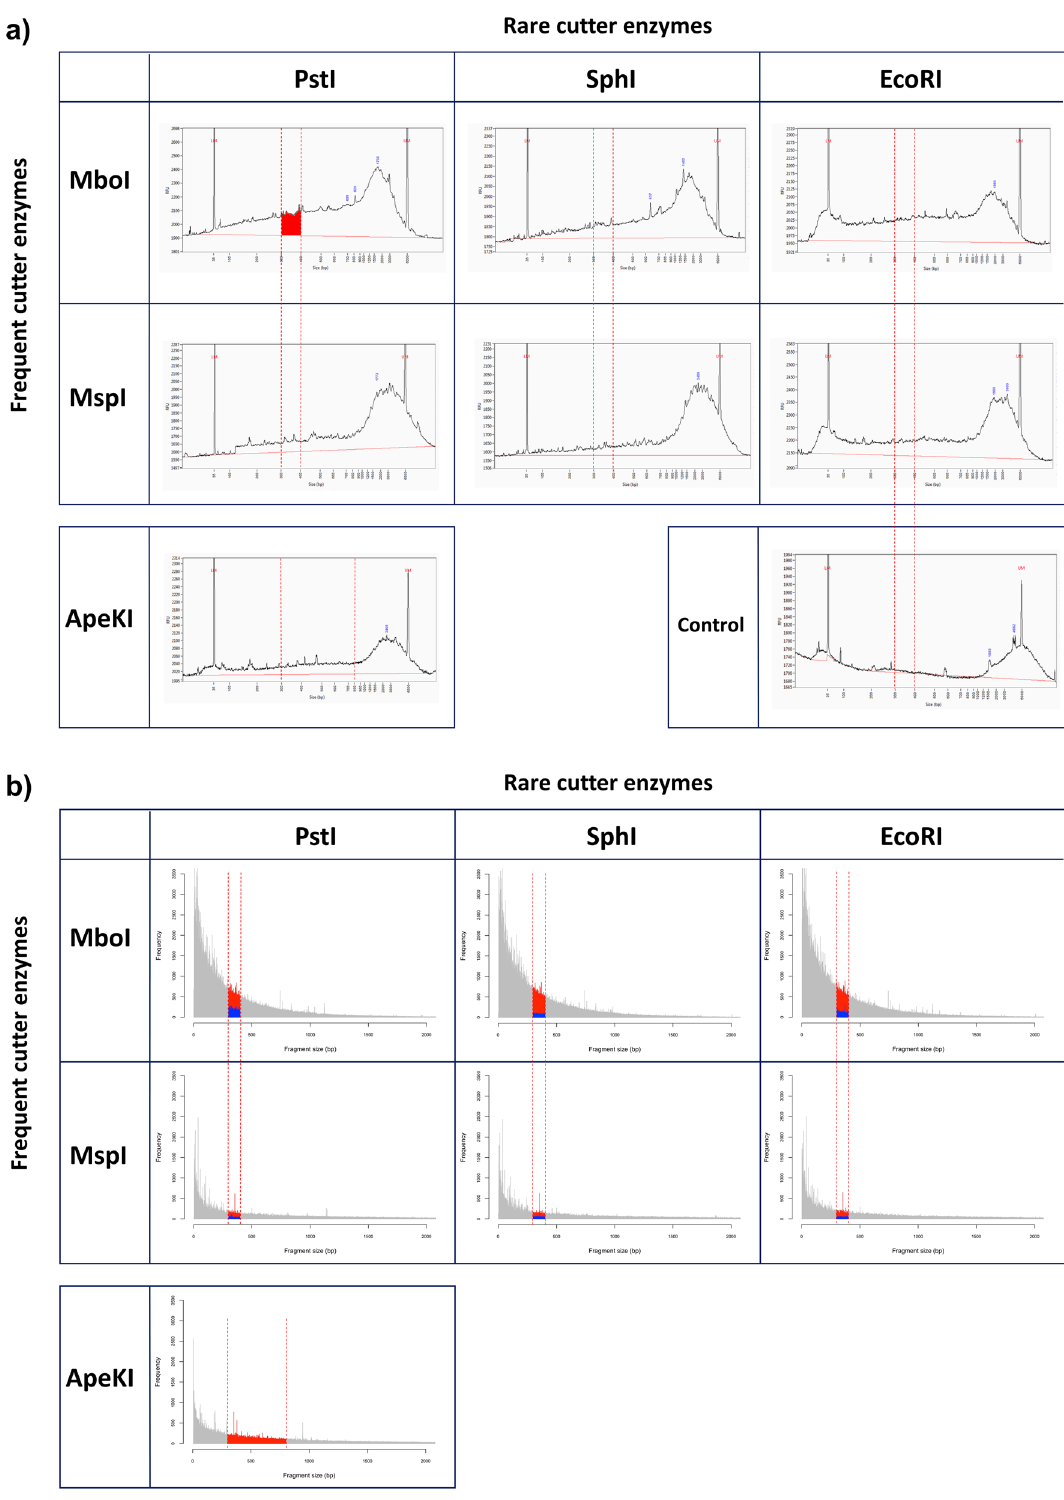
Figure 1. Reduction of genome complexity. ( a ) In vitro enzymatic restrictions. Profile of peach DNA (Dixiland) quantification by fragment analyzer (Agilent). The vertical red dashed lines indicate the region to be selected (300–400 pb for double restrictions and 300–800 pb for restriction generated by ApeKI). The larger area at the region to be selected (highlighted in red) was obtained for the combination of PstI/MboI. ( b ) In silico simulation of enzymatic restriction. Profile of the predicted restriction fragments generated using different enzyme pair combinations in the peach reference genome (v2.0). Grey area: all the restriction fragments generated by in silico digestion using one enzyme pair. Red area: fragments predicted in the range 300–400 bp. Blue area: AB + BA fragments (i.e. fragments predicted to be generated by simultaneous digestion of both restriction enzymes) in the range 300–400